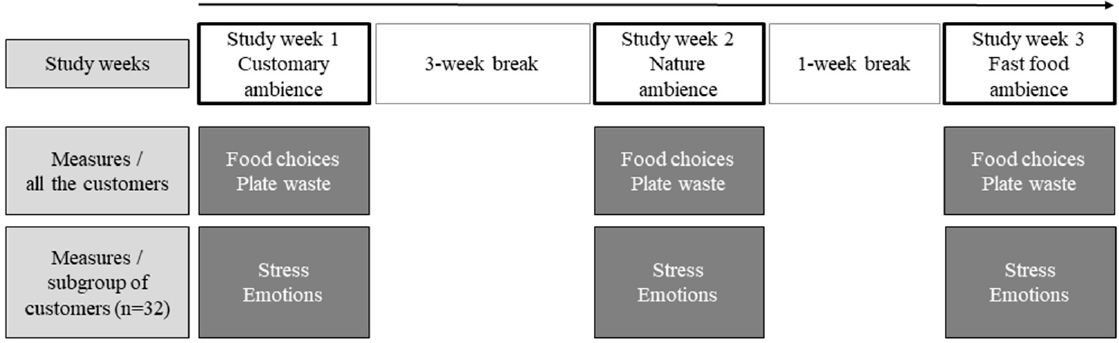
Figure 1. Overall study design with the study weeks, duration of breaks between the study weeks, measures for all customers, and measures for the subgroups of customers.